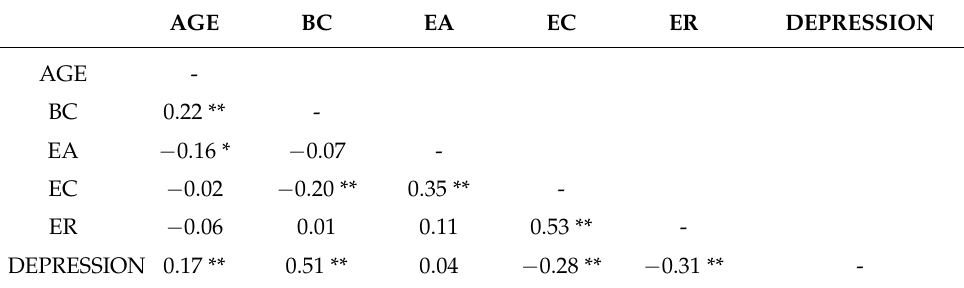
Table 2. Bivariate Pearson correlations between all the study